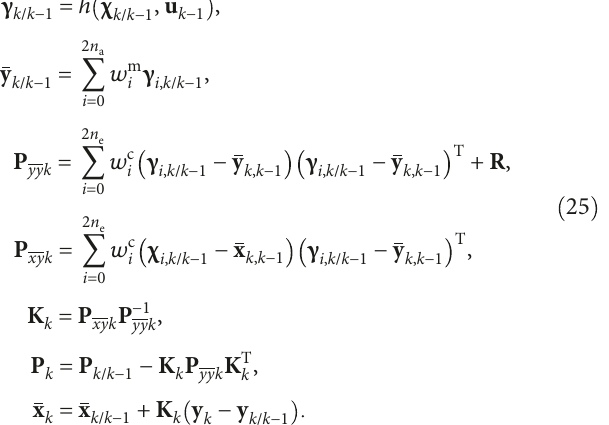
Figure 9: Coordinate y